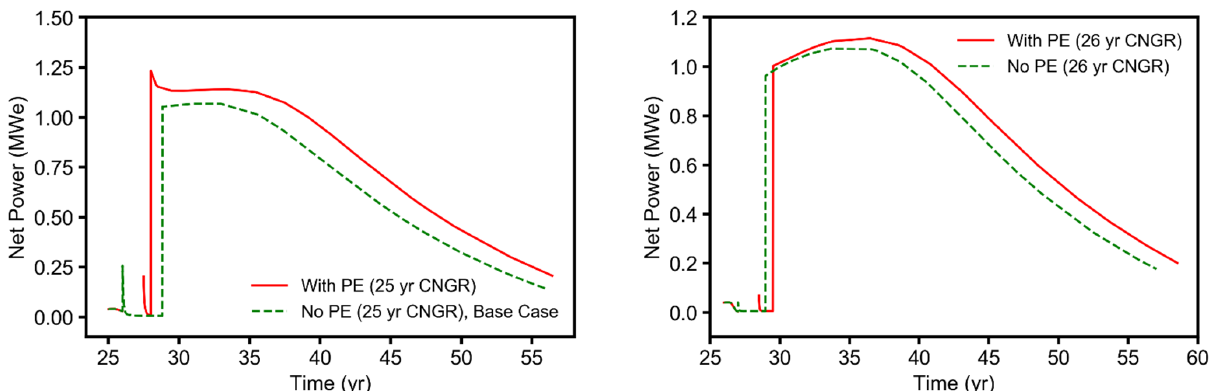
Figure A2. Simulation results (time-series plots) for the four reservoir model example cases, showing the net geothermal power generated during the EGR and CPG stages (25/26–55/56 years).